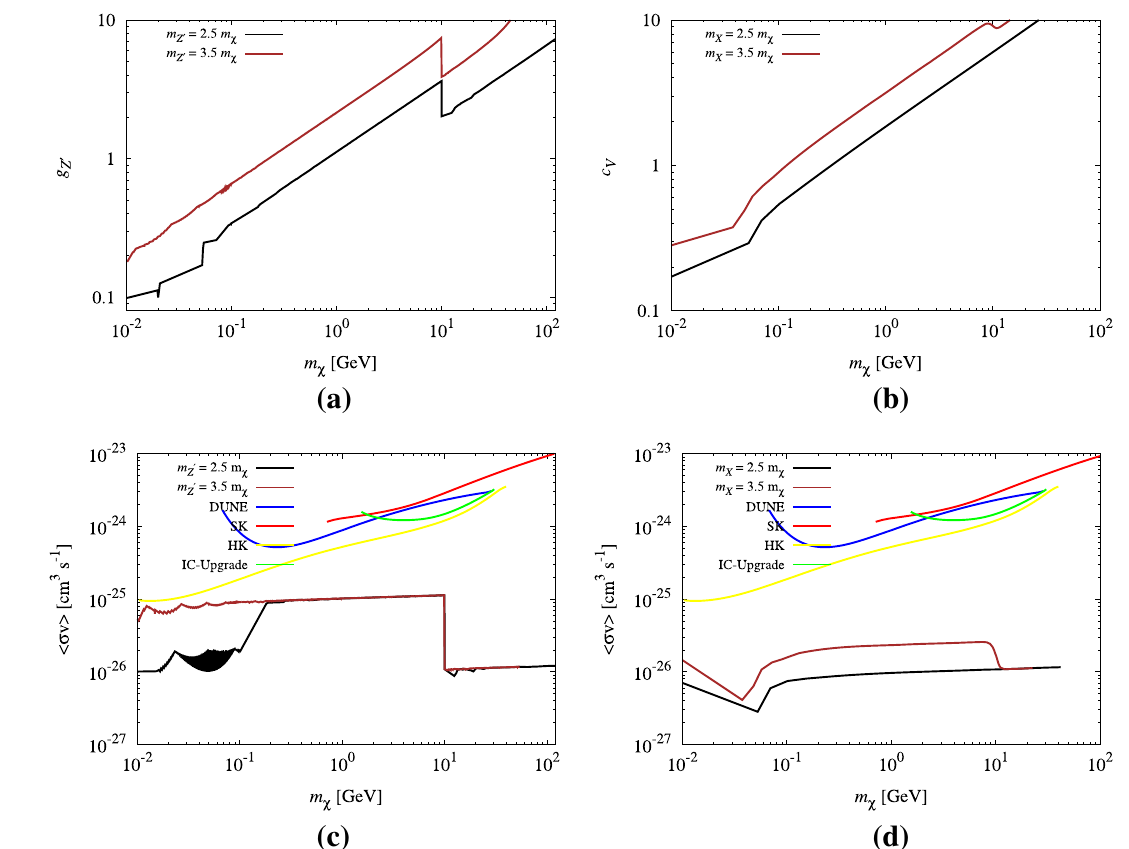
Fig. 2 Relic density and thermally averaged DM annihilation cross- section (cid:7) σ v (cid:8) plots in the neutrino-portal model. The top panel shows the relic density plots in the ( m χ − g Z (cid:2) / c V ) plane assuming that the relic density is saturated by the DM annihilation. The left and the right panels are for the s - and t -channel 4D vector mediation interactions. In